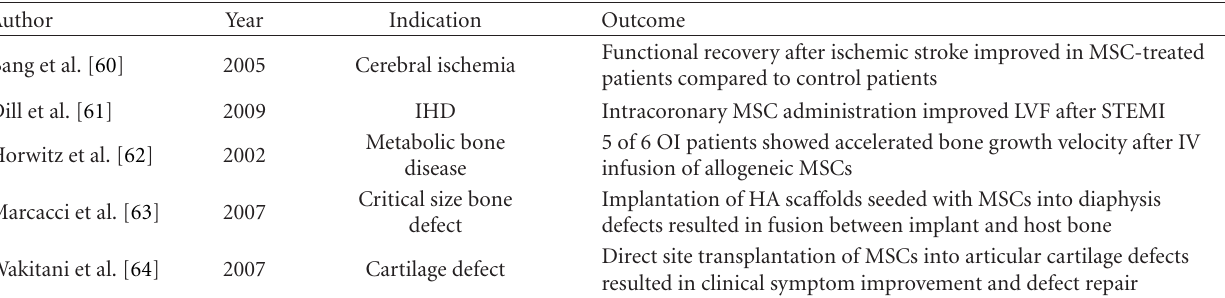
Table 1: Examples of clinical applications of mesenchymal stem